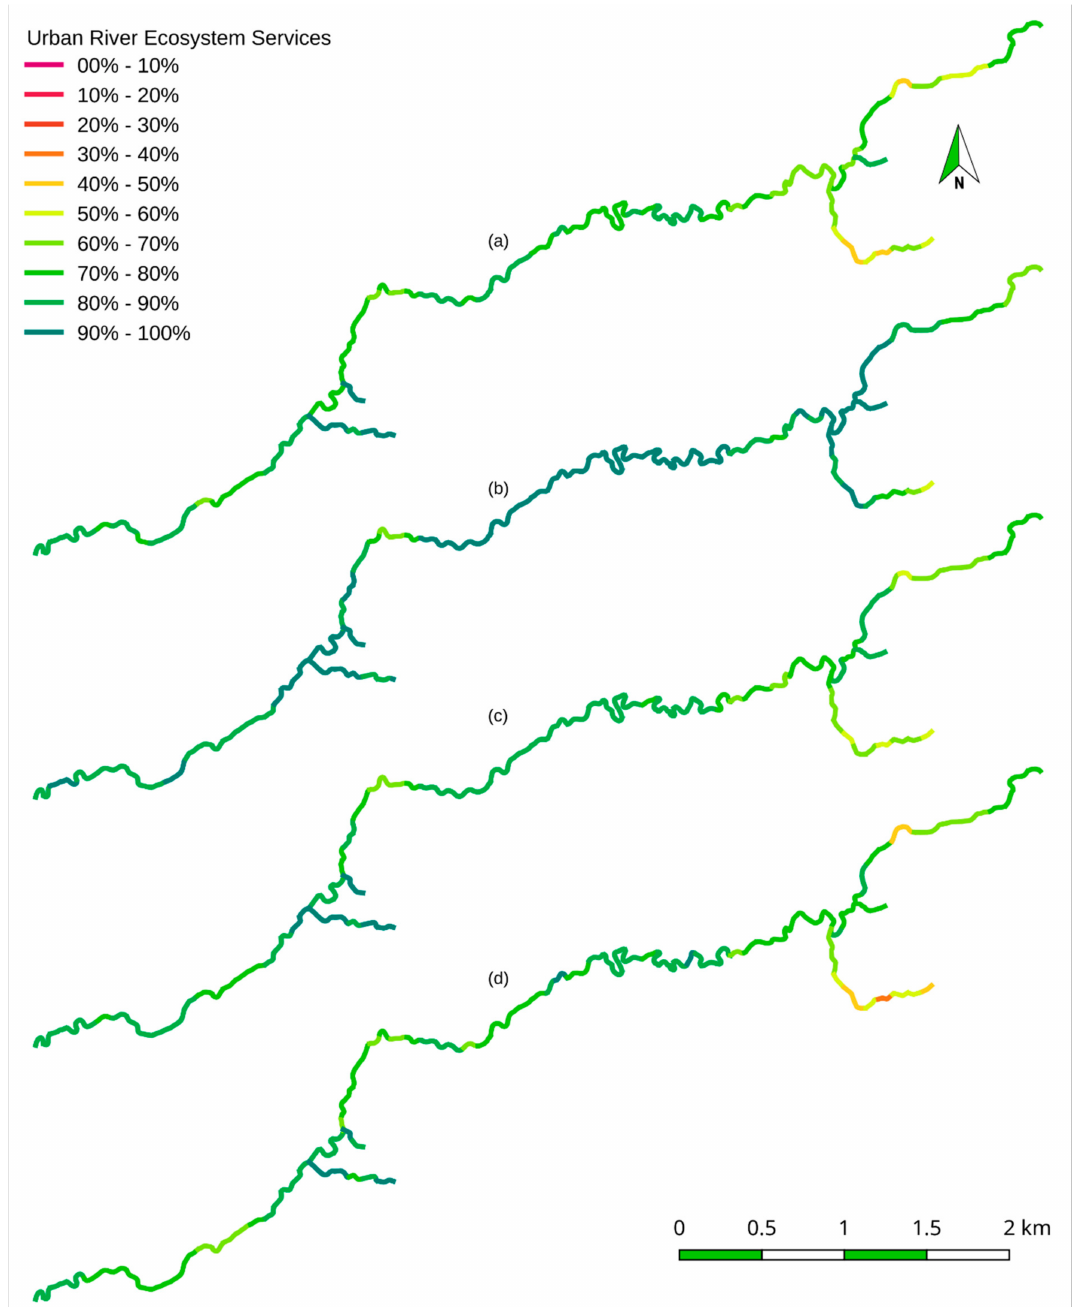
Figure 5. Maps of potential to provide Urban River Ecosystem Service for all sections of the Pochote